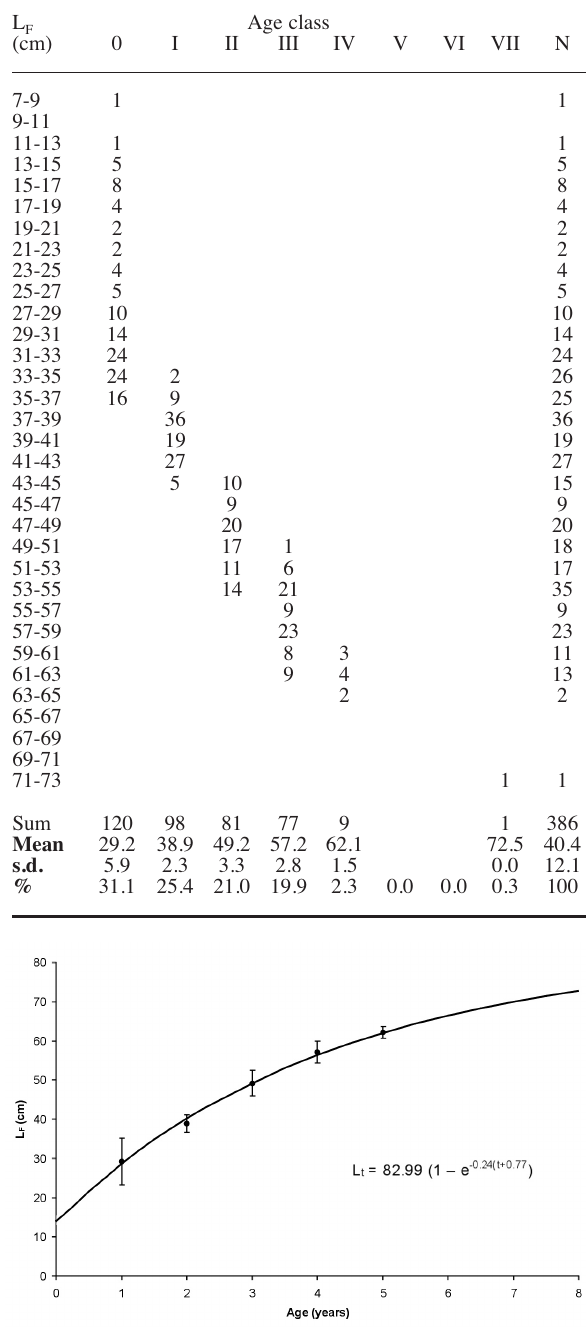
F IG . 4. – Von Bertalanffy growth curve for the Atlantic bonito, Sarda sarda, from the eastern Mediterranean Sea. Black dots indi- cates mean observed length and bars indicate standard